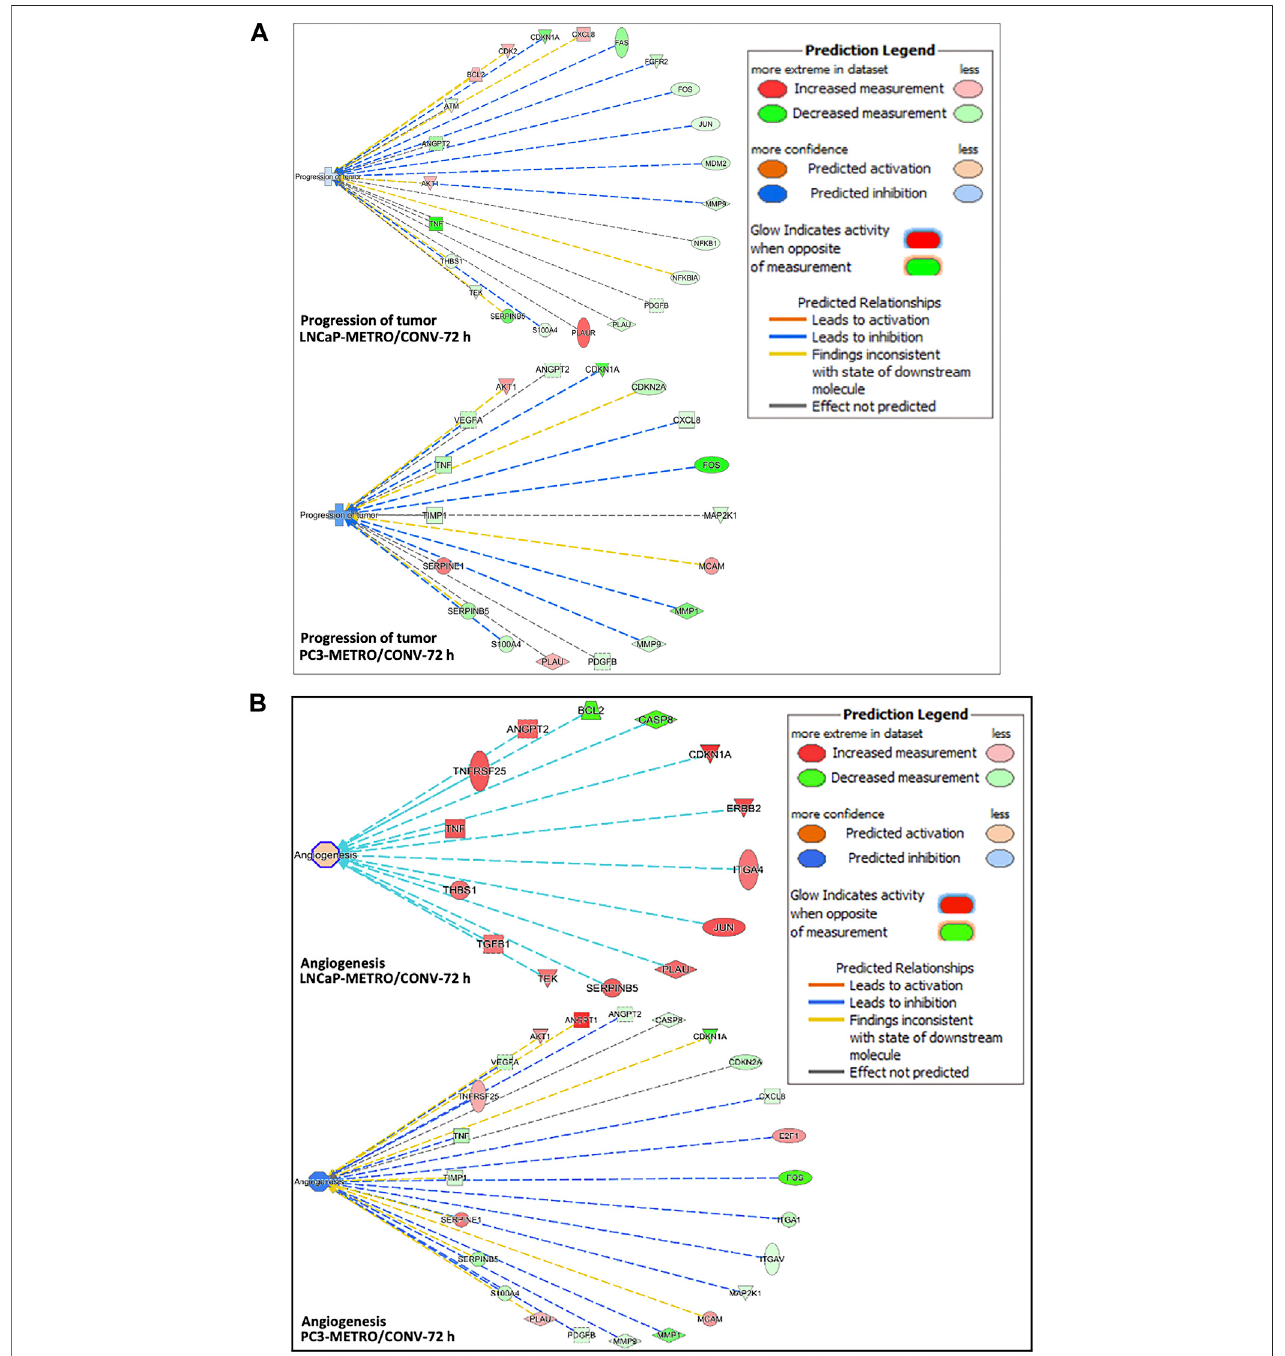
FIGURE3| Ingenuity pathway analysispredictions. (A) IPApredicted higher tumor progressioninhibition in PC-3 compared to theLNCaP cell linefollowing TOPO METRO at 72 h treatment. FOS, CDKN1A and SERPINB5, PLAUR, TNF and BCL2 are key genes in the tumor progression pathway that were expressed differentially between the two different treatment regimens, which predicted higher tumor progression inhibition for METRO-TOPO treatment. (B) Anti-angiogenesis (inhibition of angiogenesis) pathway. where METRO treatment resulted in higher downregulation in PC-3 compared to the LNCaP cell line for TOPO METRO at 72 h treatment.